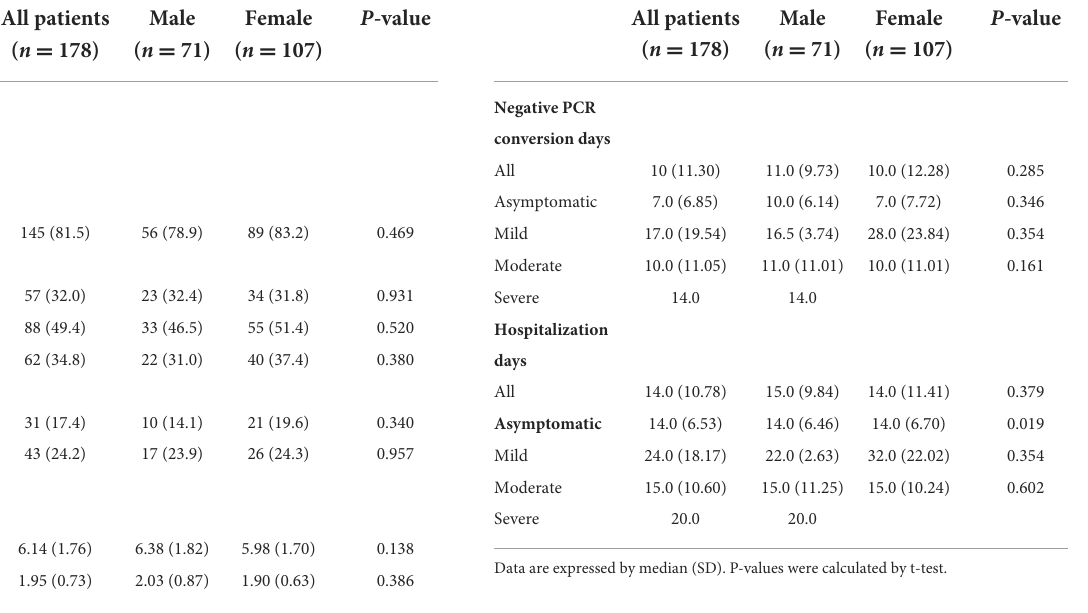
TABLE 4 Computed tomography (CT) and blood characteristics of infected subjects from overseas by gender. All patients